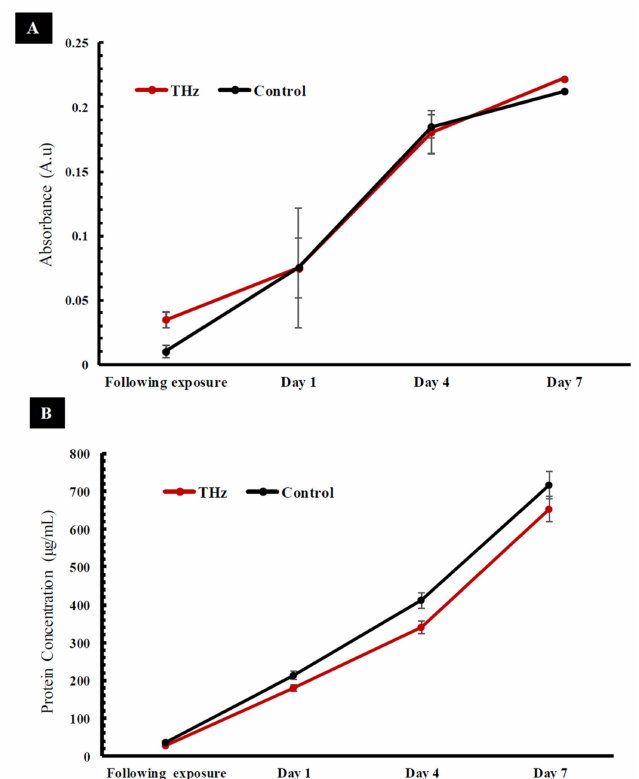
Figure 5. Term physiological analysis of PC 12 cells after THz exposure of 10 min. ( A ) Metabolic status (MTS) over the duration of 7 days and following exposure. The metabolic activity of THz treated PC 12 cells were similar to the untreated control following exposure ( p = 0.803) after day 1 and no significant changes were observed over the course of 7 days. ( B ) The total protein concentration of the THz treated sample after exposure and over a 7-day period. The total protein content of the THz treated sample was relatively low in comparison to the control straight after exposure ( p = 0.574) and over the course of 7 days. The statistical analysis of the results did not reveal a statistically significant